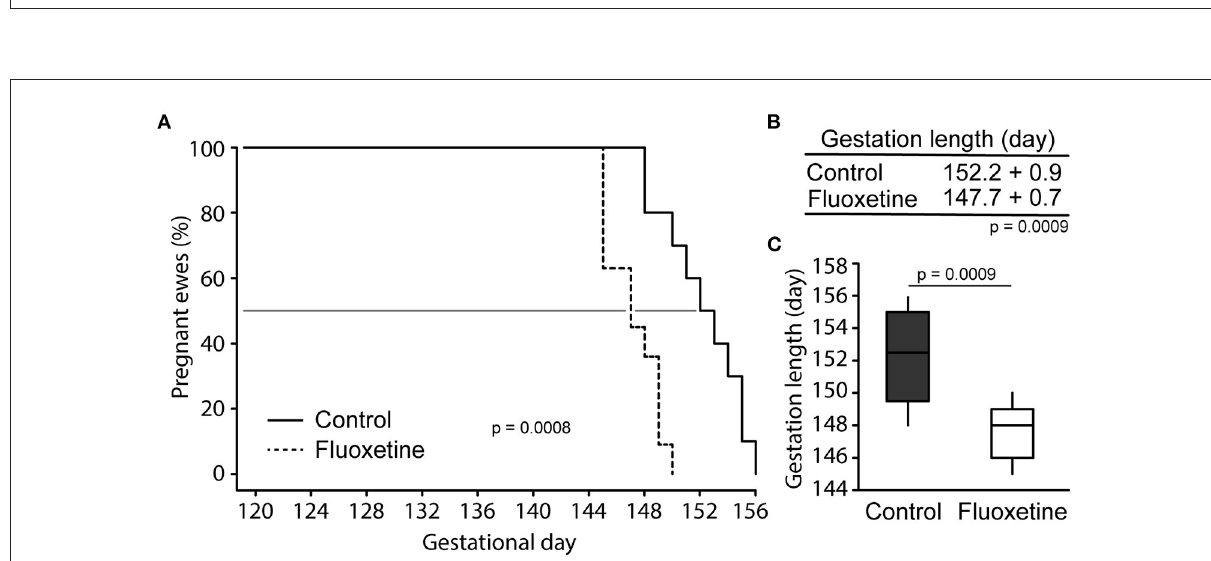
FIGURE3 Pregnancy length. (A) Survival analysis depicting number of animals giving birth each day. The 50% point is shown. (B) Mean gestation length. (C) Boxplot of gestation length. Boxplot depicts median, 10th, 25th, 75th, and 90th